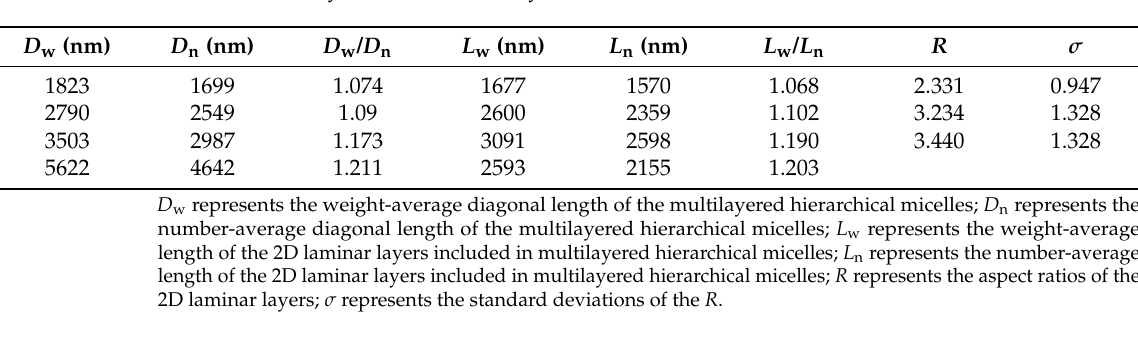
Table 1. Summary data of the multilayered hierarchical micelles.